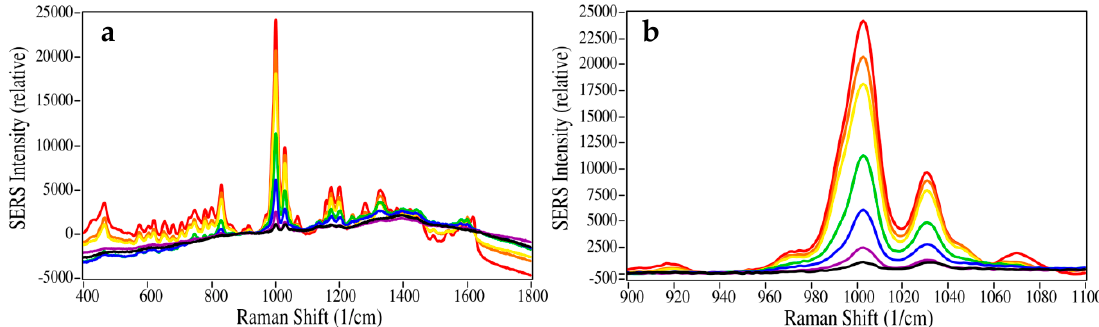
Figure 4. SERS of fentanyl at 50, 25, 10, 5, 1, 0.5, and 0.1 µg/mL. ( a ) Full spectral view as measured, and ( b ) expanded view of the 1000 cm − 1 peak. The baselines for both spectral sets were set to 0 at 940 cm − 1 . Conditions: 40 mW at 785 nm, 3-sec scan per spectrum.